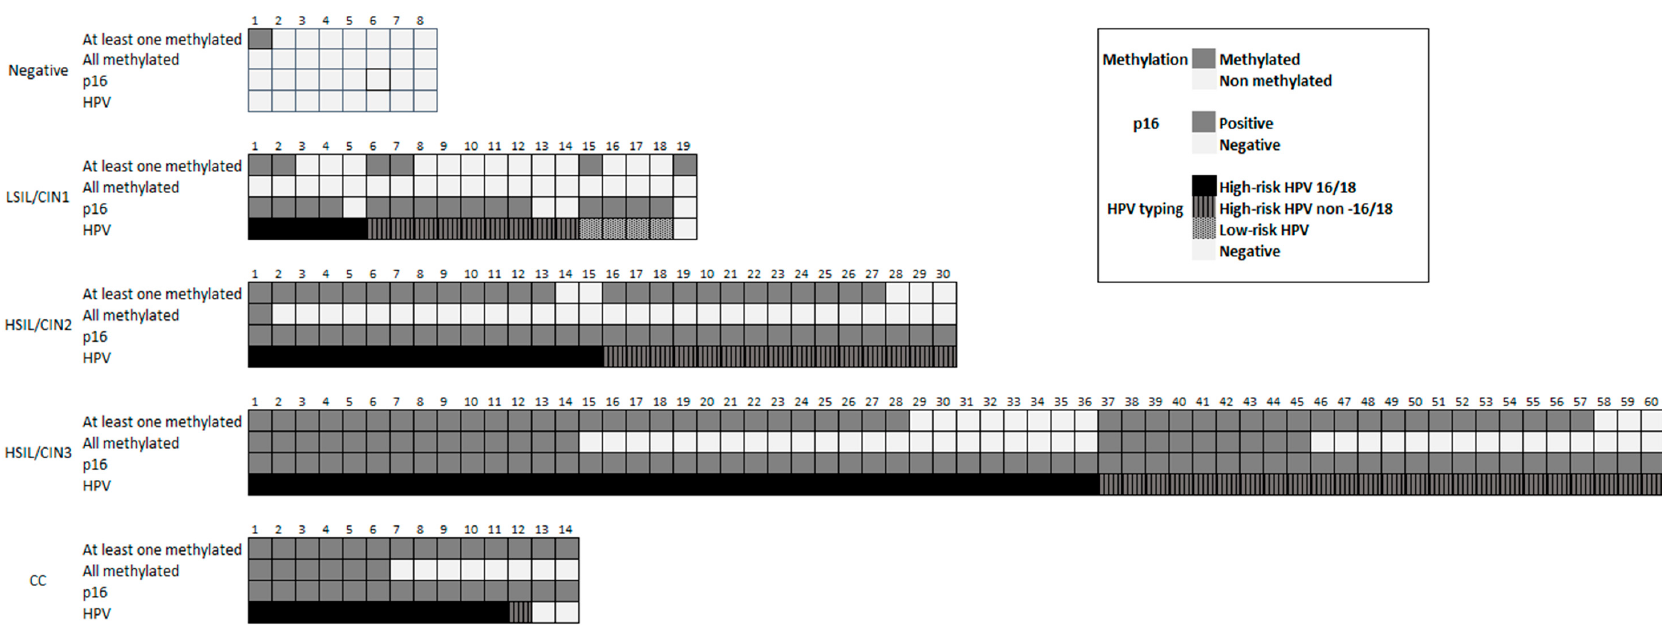
Figure 2. Results of the methylation status of CADM1, MAL, and miR124, p16 immunostaining and HPV testing and genotyping for each case in the different groups included in the study.